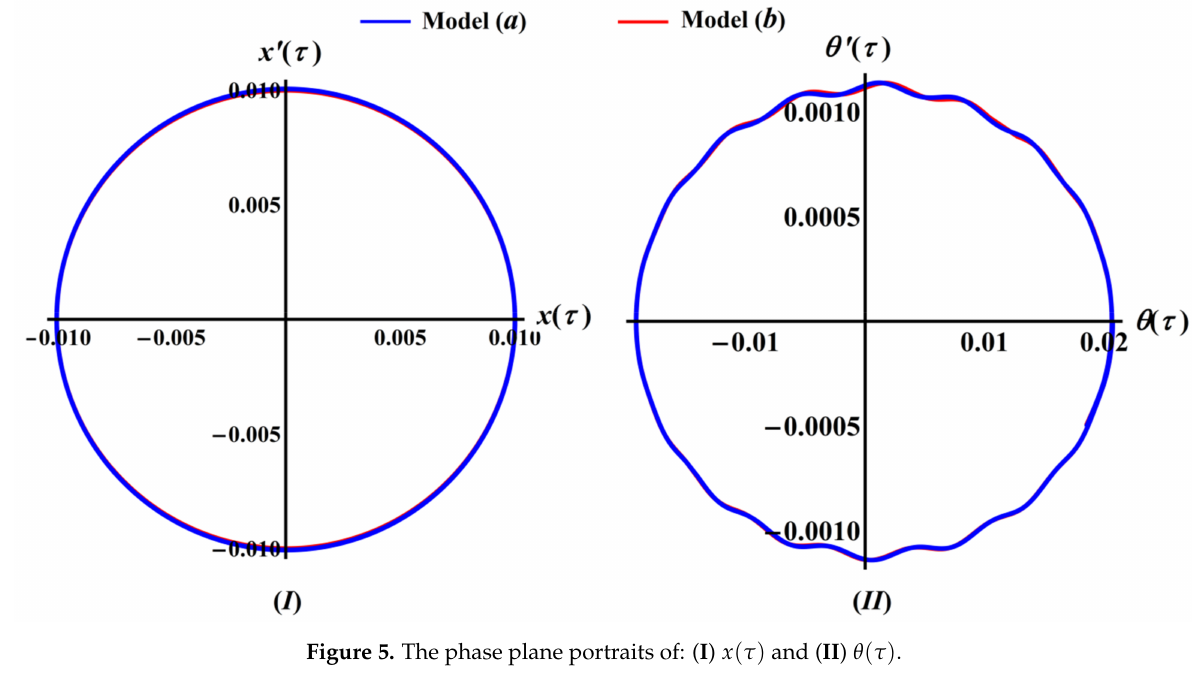
Figure 5. The phase plane portraits of: ( I ) x ( τ ) and ( II ) θ ( τ ) .